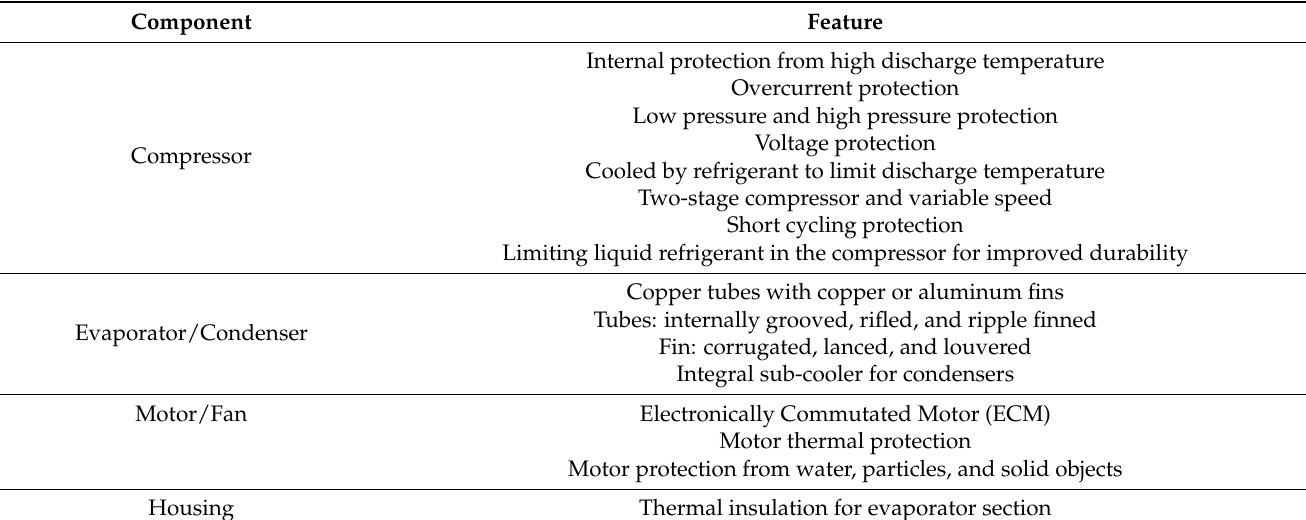
Table 5. Air conditioner design features found in HAT units sold in the GCC